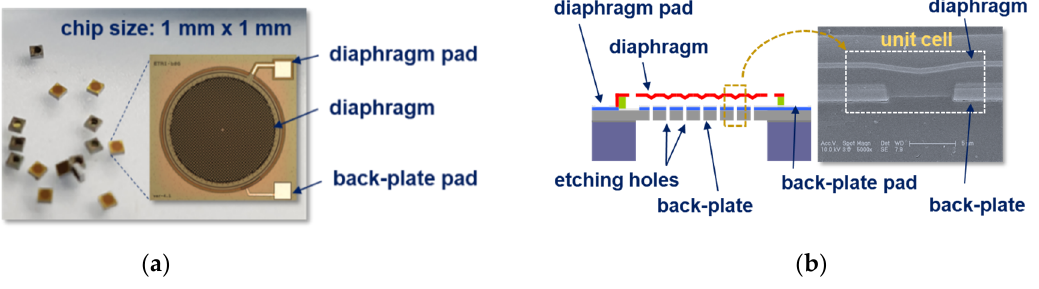
Figure 1. Schematic views and images of a capacitive MEMS acoustic sensor fabricated with a TiN/Al/TiN diaphragm: ( a ) top view; ( b ) cross section diagram and a SEM image.